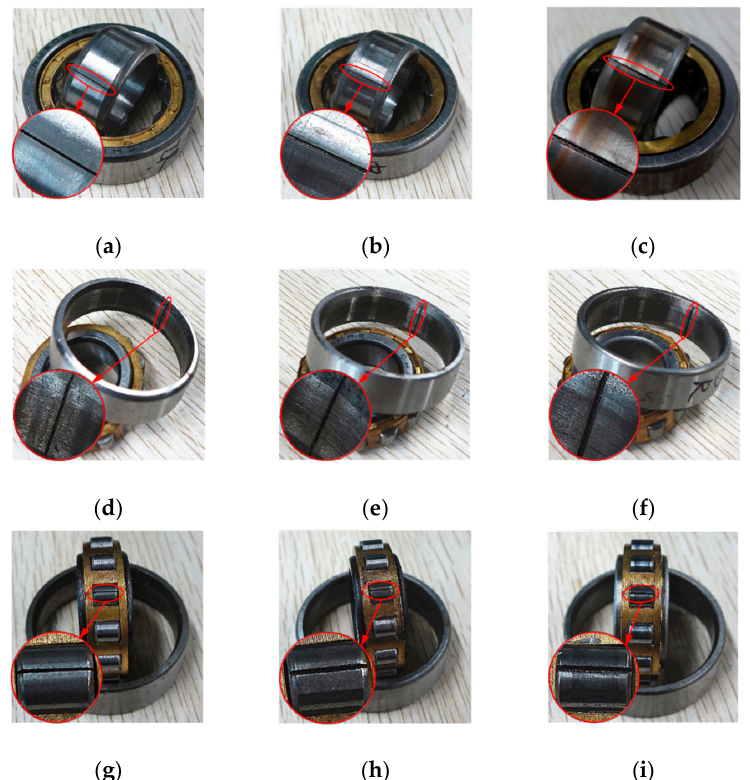
Figure 6. Bearing with different fault types and fault sizes: ( a ) IF, 0.18 mm, ( b ) IF, 0.36 mm, ( c ) IF, 0.54 mm, ( d ) OF, 0.18 mm, ( e ) OF, 0.36 mm, ( f ) OF, 0.54 mm, ( g ) RF, 0.18 mm, ( h ) RF, 0.36 mm, ( i ) RF, 0.54 mm.